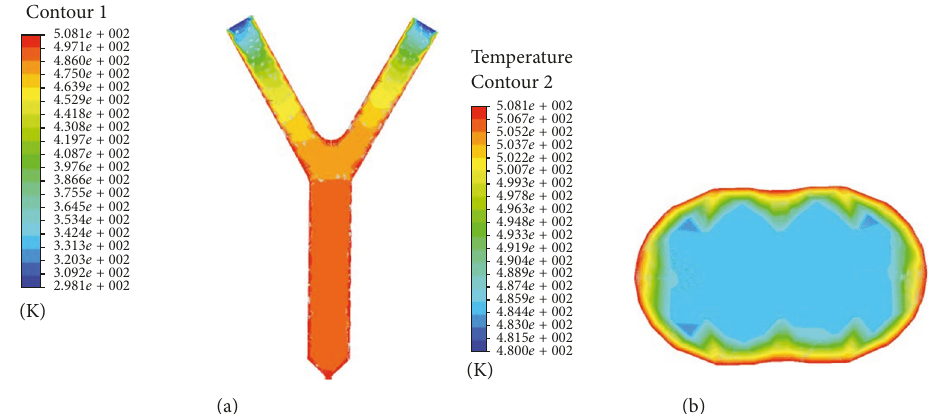
Figure 10: Temperature contours in the steady state at the temperature of 508.15 K at the time of 10 s: (a) temperature contours of the flow channel; (b) temperature contours of the intersection cross section.